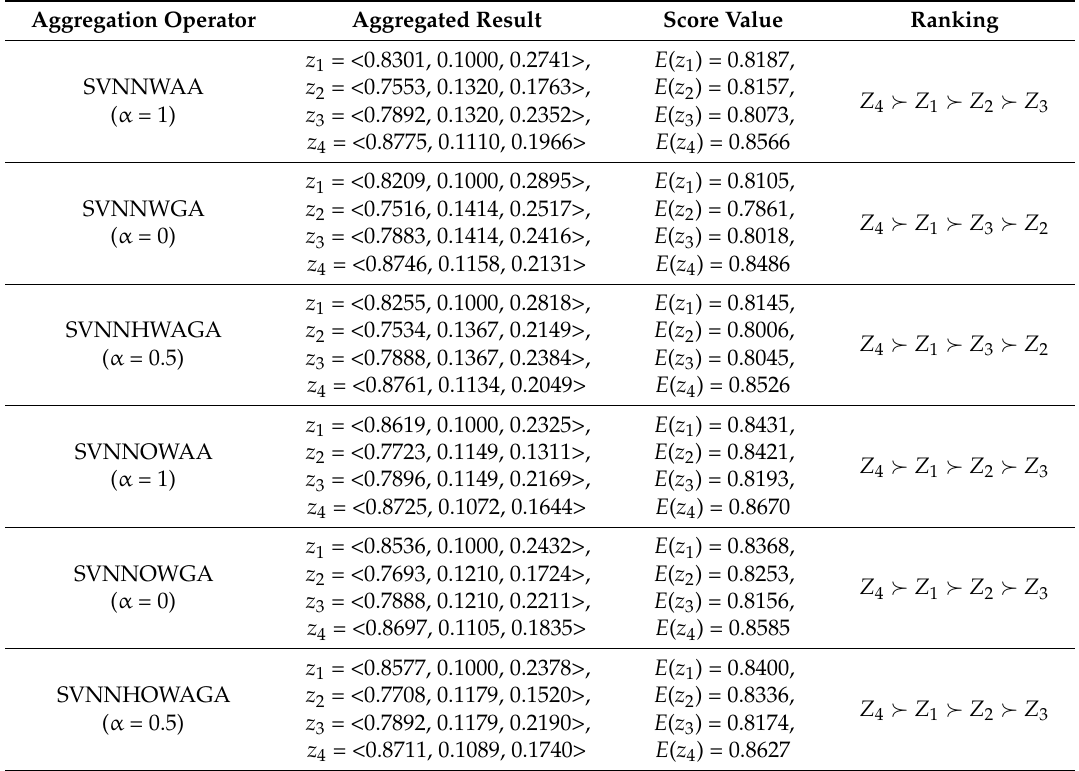
Table 2. Decision-making results of different aggregation